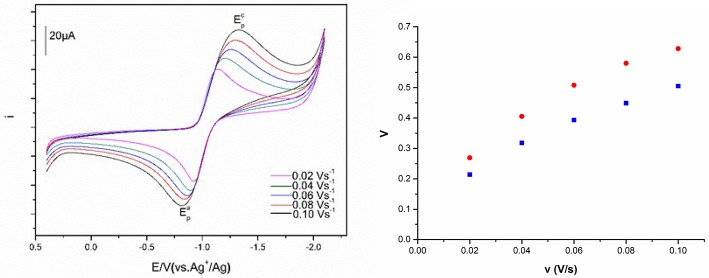
Cyclic voltammograms of Eu(III) measured in [C4m2im][N(CN)2] and the peak potential separation values of [C4m2im][N(CN)2] (blue) and N8444[N(CN)2] (red) at different scan rates.